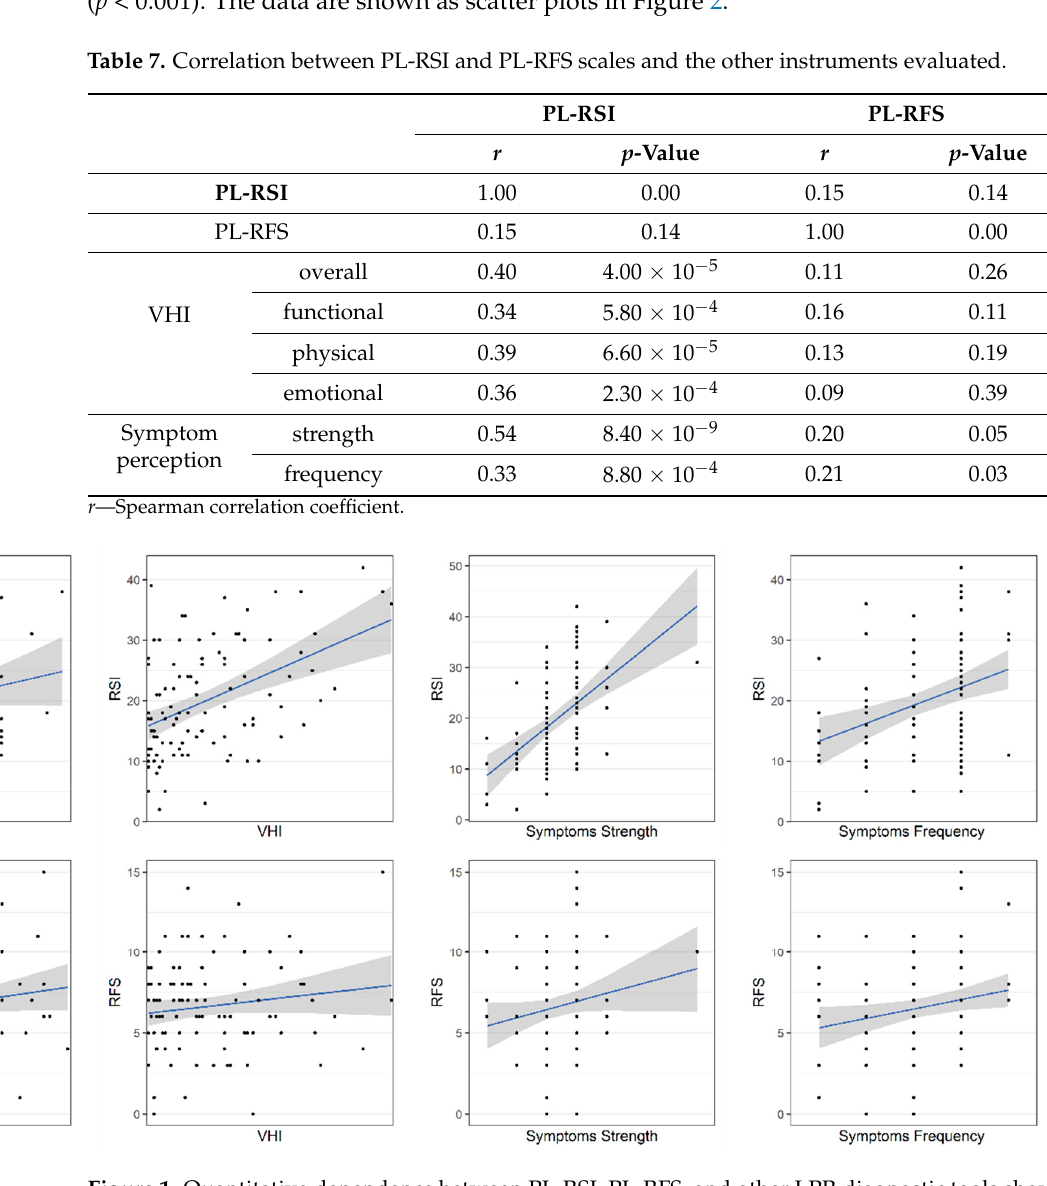
Figure 1. Quantitative dependence between PL-RSI, PL-RFS, and other LPR diagnostic tools shown as scatter plots and fitted linear regression lines. Grey areas indicate 95% confidence intervals.